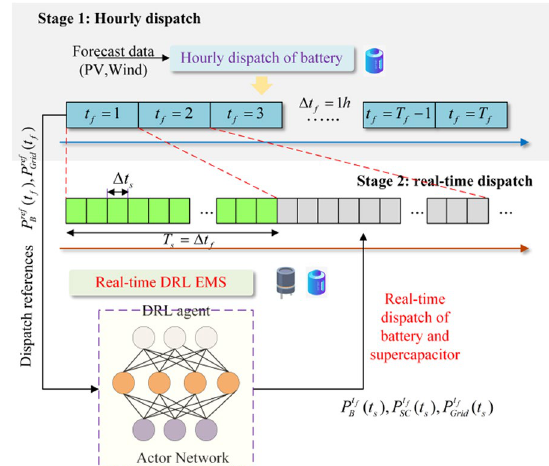
Fig. 2 Framework of the proposed DRL based multi-timescale coordinated microgrid